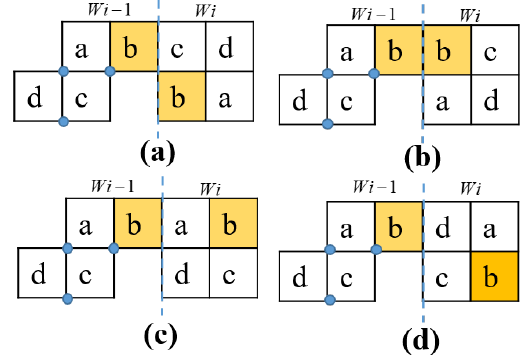
Figure 11. The distance between each block of two sample shapes of hTetro.( a ) option 1; ( b ) option 2; ( c ) option 3; ( d ) option